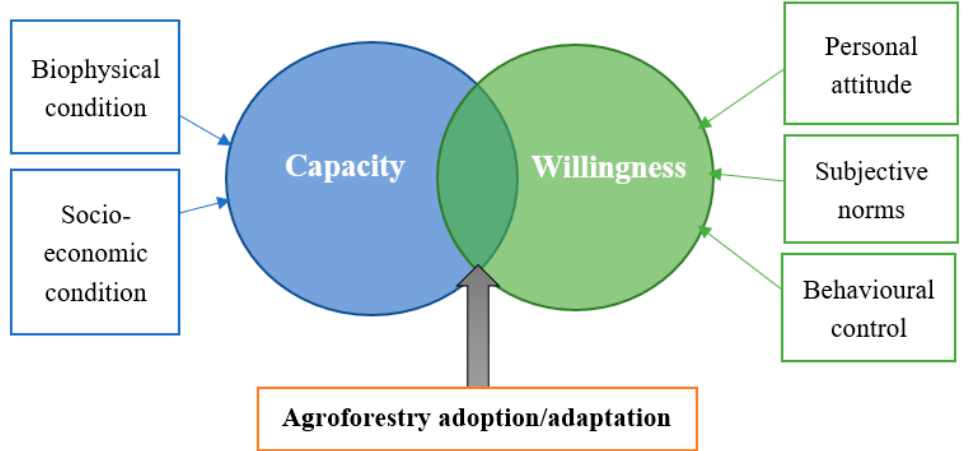
Figure 1. Farmer’s capacity and willingness for pathways towards agroforestry adoption (adapted from Ajzen [31] and Mills et al. [61]).